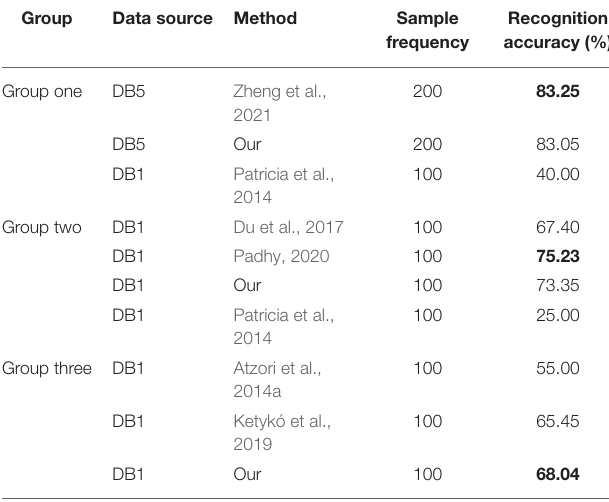
TABLE 2 | Comparison of results with other